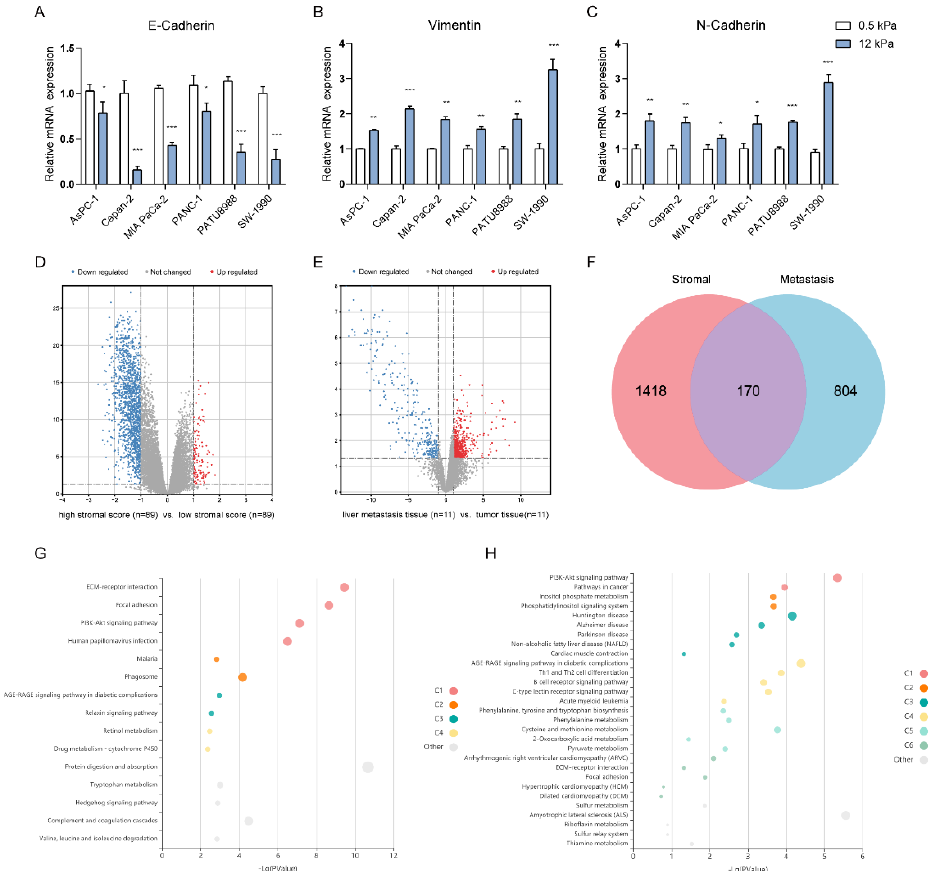
Figure 2. Exploration of Stroma- and Metastasis-Associated Genes. ( A – C ) Simulation of the effect of different matrix stiffness on the expression of key genes in EMT In vitro; ( D ) Volcano plot of stroma- associated DEGs based on TCGA-PAAD data; ( E ) Volcano plot of metastasis-associated DEGs based on RenJi cohort transcriptomics data; ( F ) Venn diagrams for screening stroma- and metastasis-asso- ciated genes; ( G ) Top 15 GO analysis terms for stroma- and metastasis-associated genes; ( H ) Stroma- and metastasis-associated genes of the top 30 most enriched KEGG pathways. * p < 0.05, ** p < 0.01, *** p < 0.001.